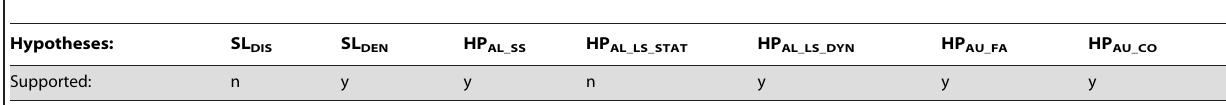
Table 2. Hypotheses assessment